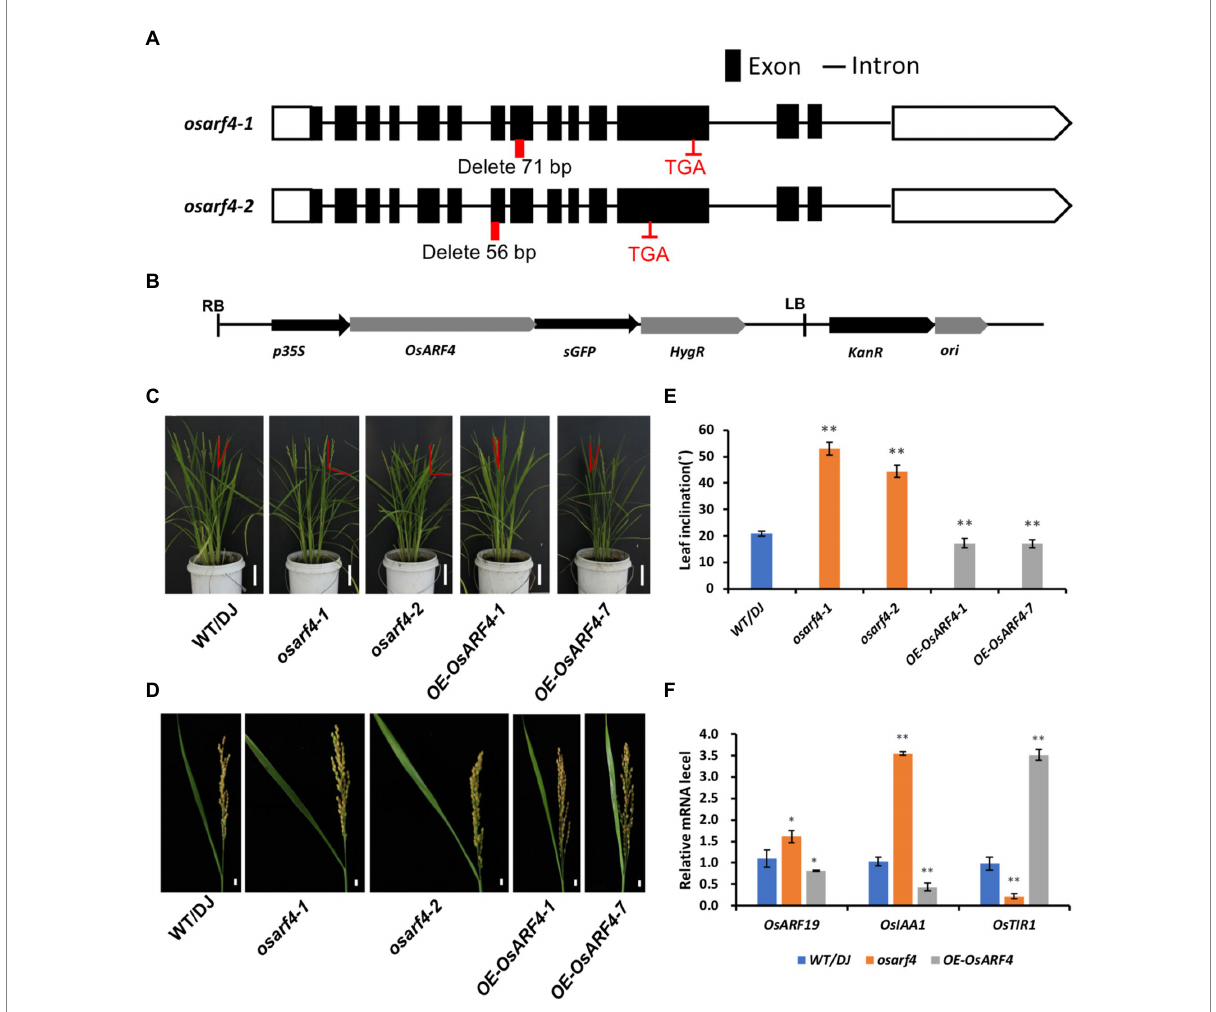
FIGURE 2 Phenotypic characterization of OsARF4 . (A) Construction of two osarf4 mutants using CRISPR/Cas9 technology. Black lines, black boxes, and red boxes indicate introns, exons, and editing sites, respectively. TGA is a stop codon. (B) Map of the OsARF4- overexpressing vector. (C) Phenotypes of 3-month-old seedlings of WT/DJ, osarf4 mutants ( osarf4-1 and osarf4-2 ), and OsARF4- overexpressing lines ( OE-OsARF4-1 and OE-OsARF4-7 ). Bars = 10 cm. (D) Flag leaf angles of WT/DJ, osarf4 mutants, and OsARF4- overexpressing seedlings at mature stages. Bars = 3 cm. (E) Quantification of flag leaf angles at mature stages. Ten biological replicates were taken for each experiment. ** indicates a significant difference at p < 0.01. (F) Relative expression levels of leaf inclination-related genes in WT/DJ, osarf4 mutants, and OsARF4 -overexpressing lines. Three individual biological replicates were taken for each experiment. * p < 0.05 and ** p < 0.01 indicate significant differences compared with WT/DJ using Student’s t